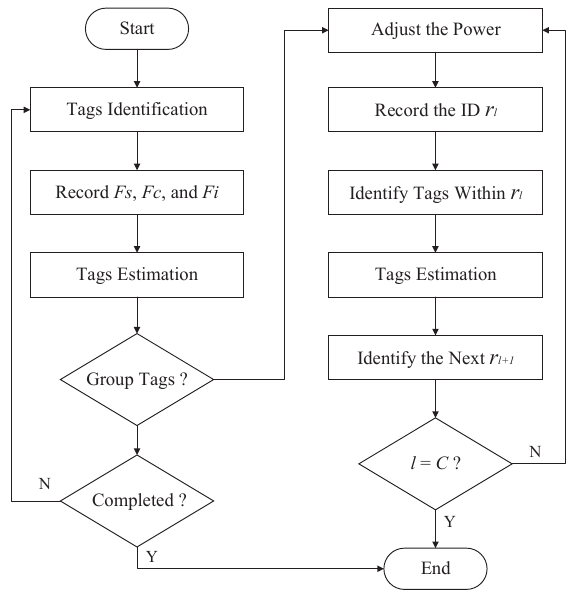
Figure 5. Flowchart for the proposed tag anti-collision